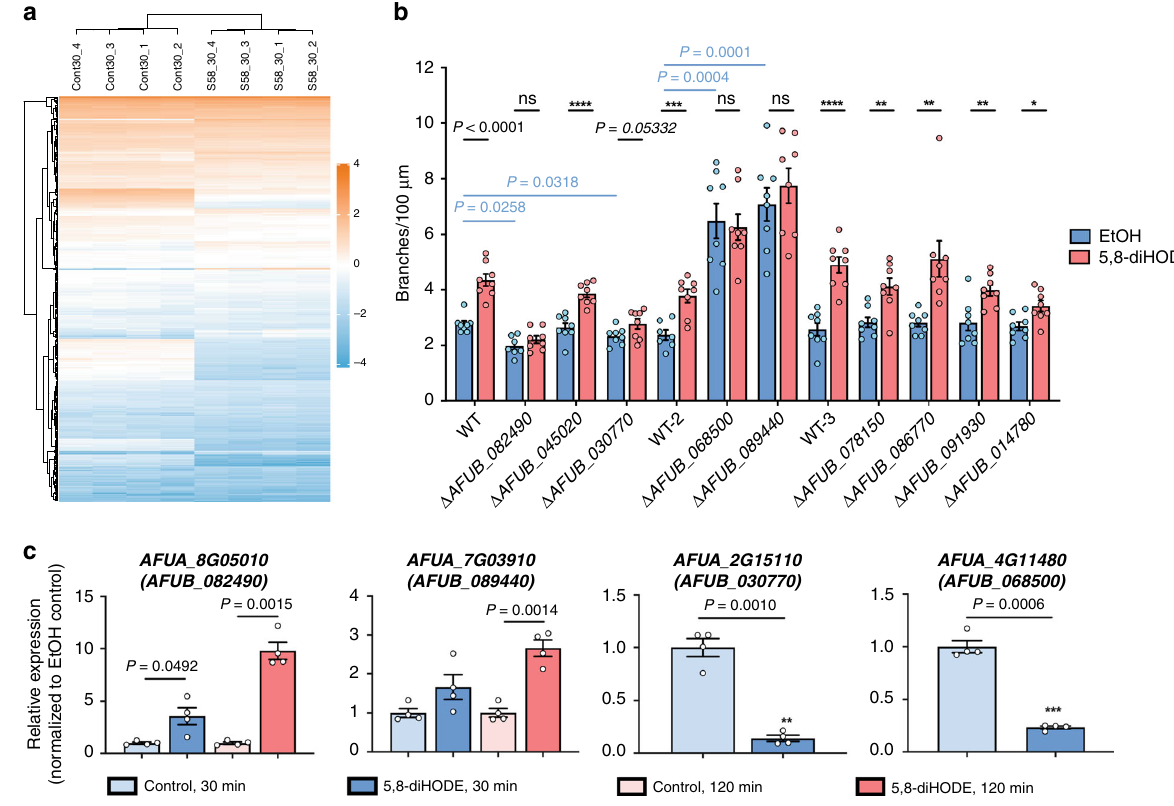
Fig. 5 Global response to 5,8-diHODE and transcriptional regulators involved in 5,8-diHODE-induced branching. a Hierarchical clustering analysis of differentially expressed genes (DEGs) with FDR < 0.05 and |log 2 FC|>1 at 30 min post treatment from RNA-seq experimentation. The log 2 FPKM (fragments per kilobase of transcript per million mapped reads) were used to construct the heatmap using the ComplexHeatmap package in RStudio. Cont_30: EtOH controls at 30 min; S58_30: 5,8-diHODE treated samples at 30 min. b Micro fl uidic-based screen of transcription factor (TF) mutants ( n = 7 for Δ AFUB_082490 and WT-2 in EtOH group, and n = 8 for the rest). Nine TF mutants from the fi rst round of the screen were evaluated for branching in GMM containing EtOH or 5,8-diHODE (5 µ g/mL) in four micro fl uidic wells in three separate batches. A1160 pyrG + WT control was used as a positive control for each batch. For each treatment group in each strain, eight hyphae randomly selected from four micro fl uidic wells were imaged every 15 min for 5 h. P values corresponding to asterisks (*) from left to right are: <0.0001, 0.0005, <0.0001, 0.0026, 0.0038, 0.0041, 0.0105. c Expression